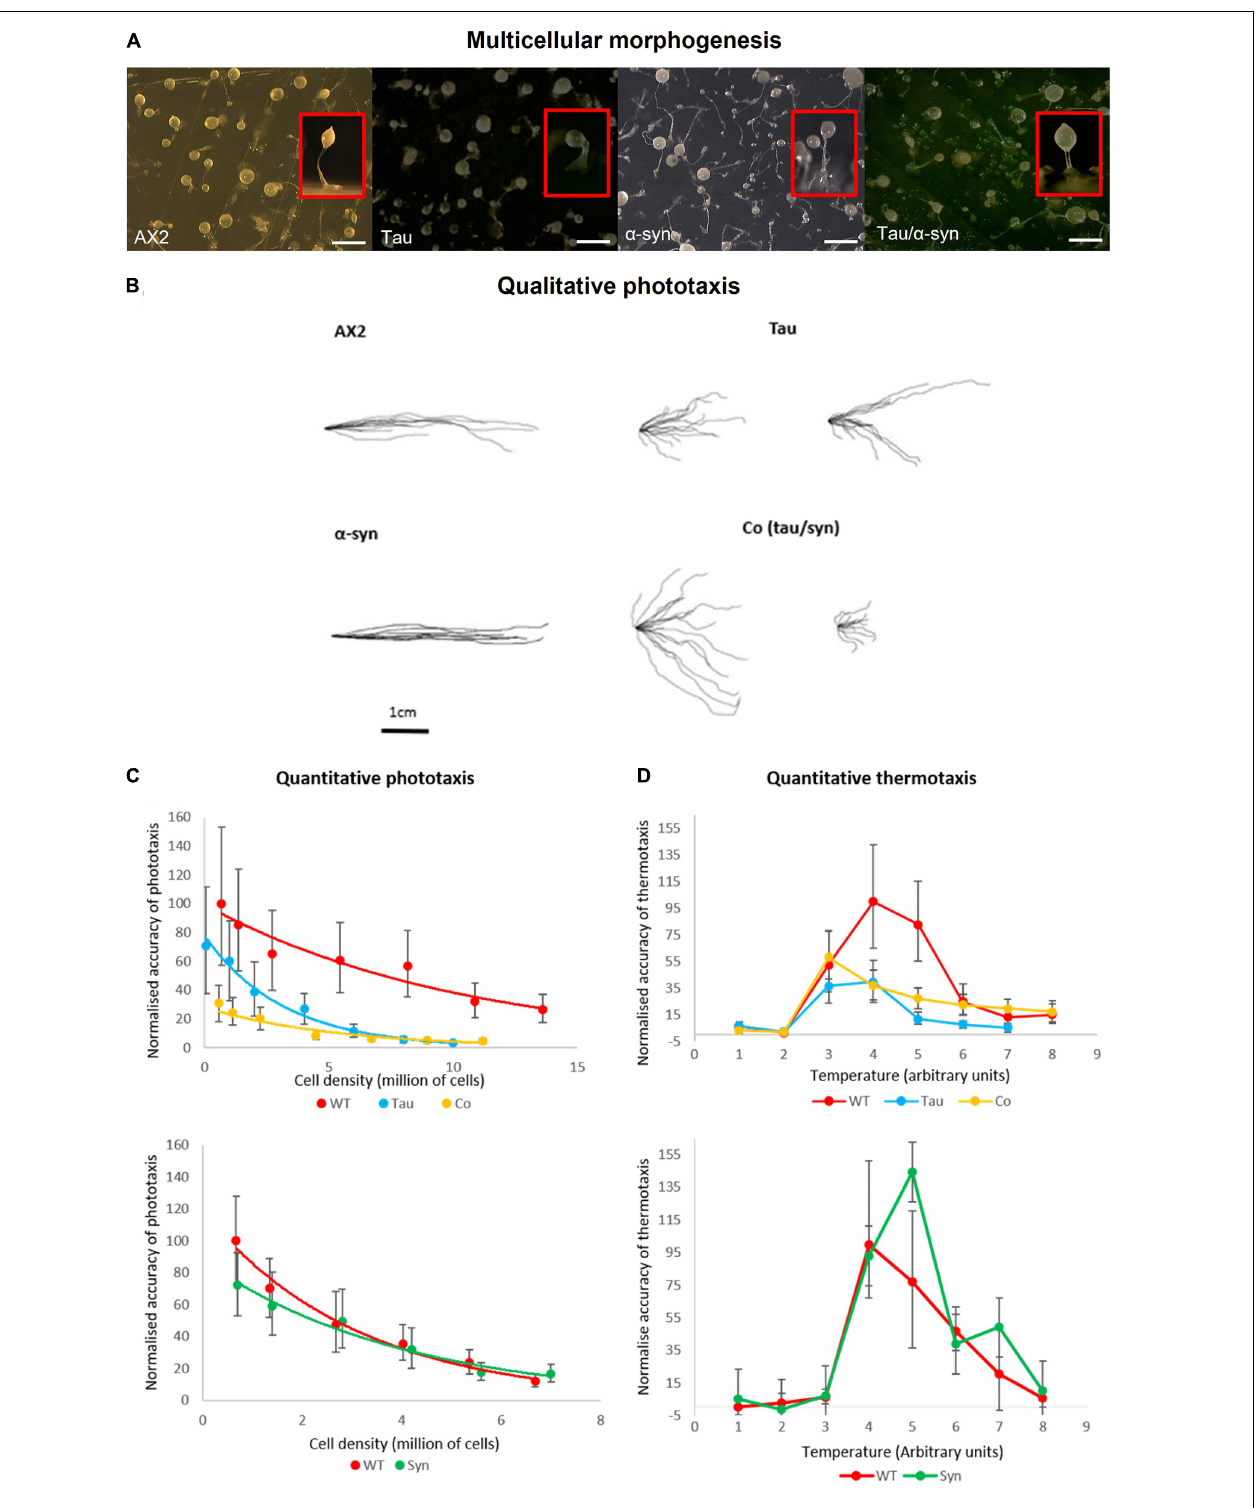
FIGURE 3 | Multicellular morphogenesis, phototaxis and thermotaxis. (A) Fruiting body morphology by AX2, strains expressing tau and α -synuclein singularly and coexpression of the two proteins. Tau strains produce an abnormal stalk with enlarged basal disk when compared to the parental strain. The α -synuclein strains resemble that of the parental strain AX2 (Fernando et al., 2020). The strains expressing both tau and α -synuclein have a thicker stalk and larger sorus indicating that these strains produce larger aggregates than AX2. Top view of plates with insets showing the side view of a single representative fruiting body of each strain.